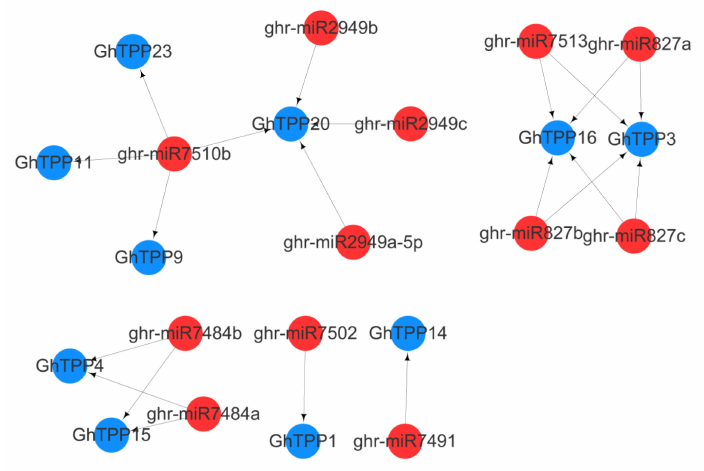
Figure 6. Prediction of miRNAs targeting TPP genes. The red circles reflect the predicted miR- NAs, and the blue circles depict the targeted TPP genes. The lines between the circles represent their